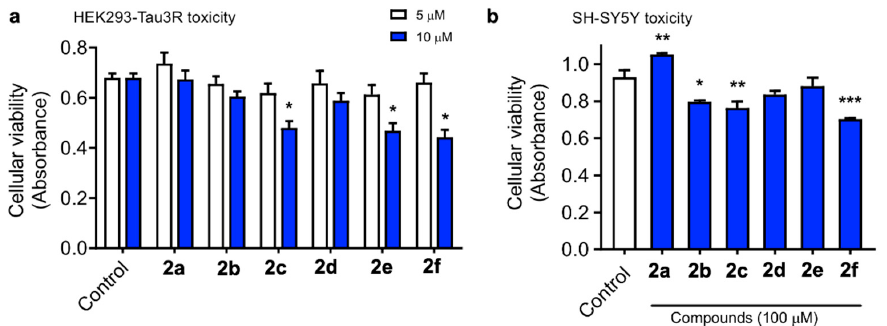
Figure 1. HEK293-Tau3R cells were treated with compounds 2 at 5 and 10 μ M concentrations for 24 h ( a ). Similarly, SH-SH5Y cells were treated with the tested compounds at 100 μ M concentration for 24 h ( b ). Cell viability was then measured by the MTT assay, and the data obtained are expressed as the mean ± S.E.M. of three independent experiments. Significant differences were found in the optical density (OD, 545 nm) values elicited by the addition of 10 µ M 2c , 2e and the curcumin standard